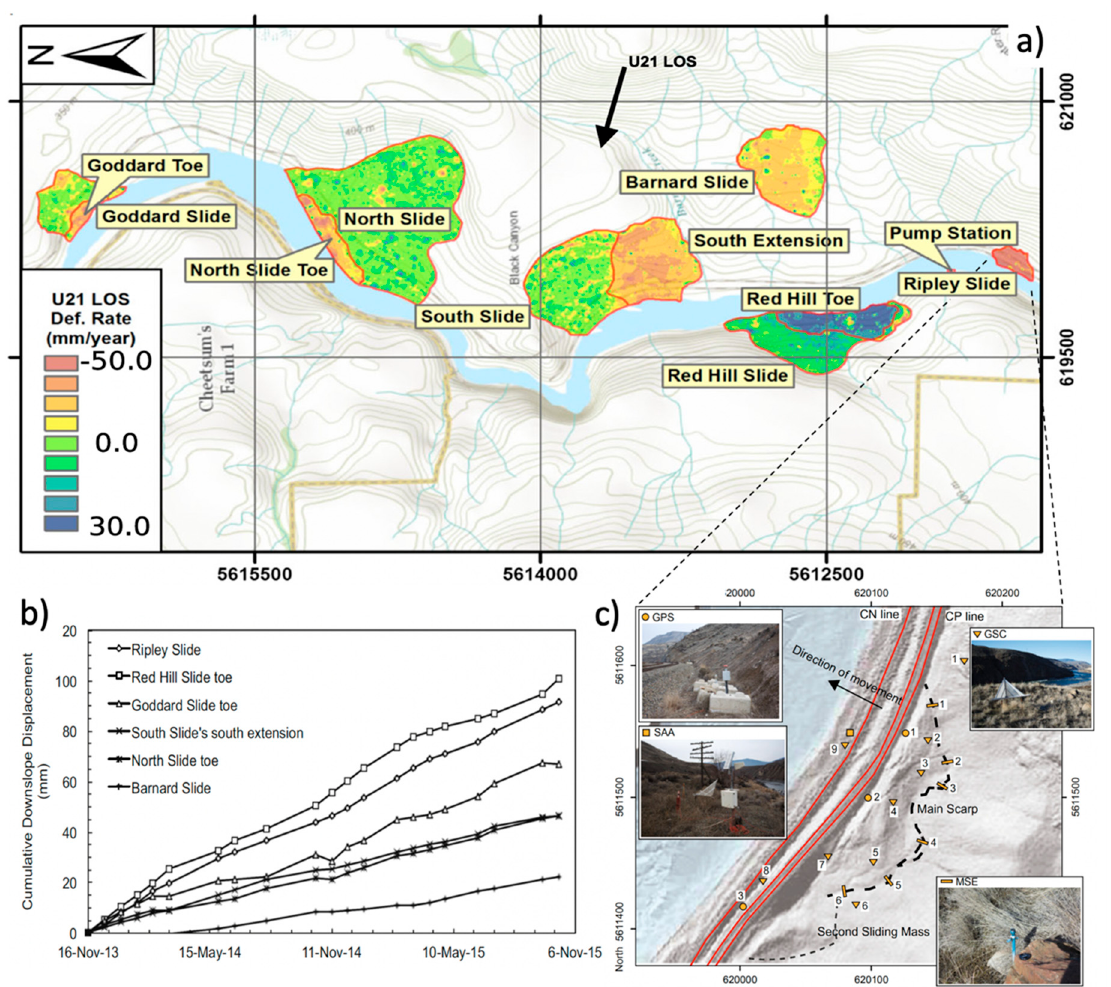
Figure 9. Line of Sight (LOS) displacement rates from Satellite InSAR at the active landslides ( a , b ). Location of some in-place instrumentation at the Ripley Landslide (GSE are corner reflectors, MSE are manual survey rods) ( c ). Adapted from [44,48].